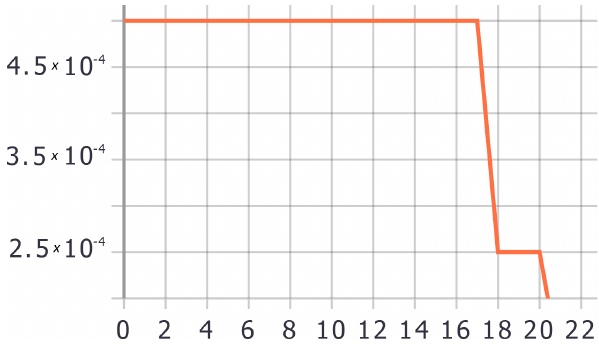
Figure 8. Learning rate among the